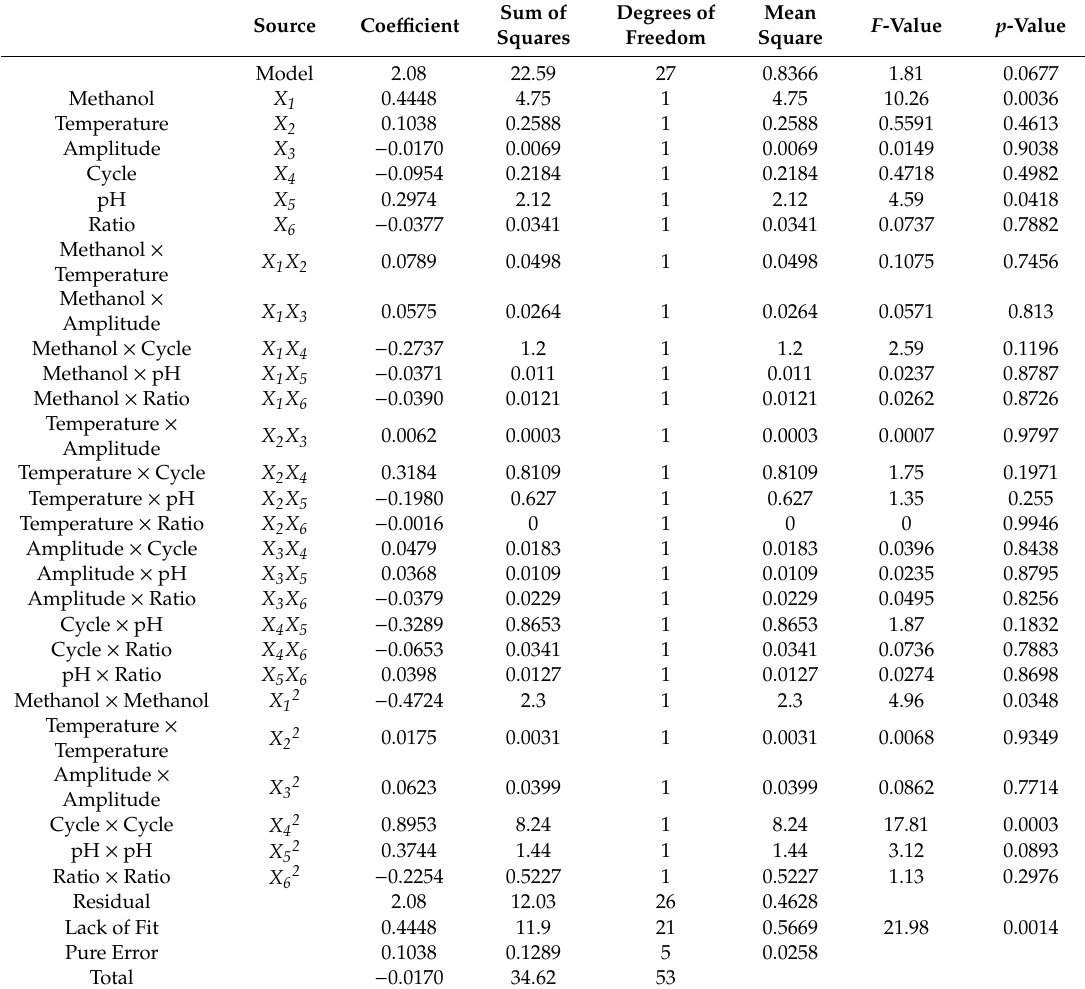
Table 2. ANOVA for the response surface quadratic model for total phenolic